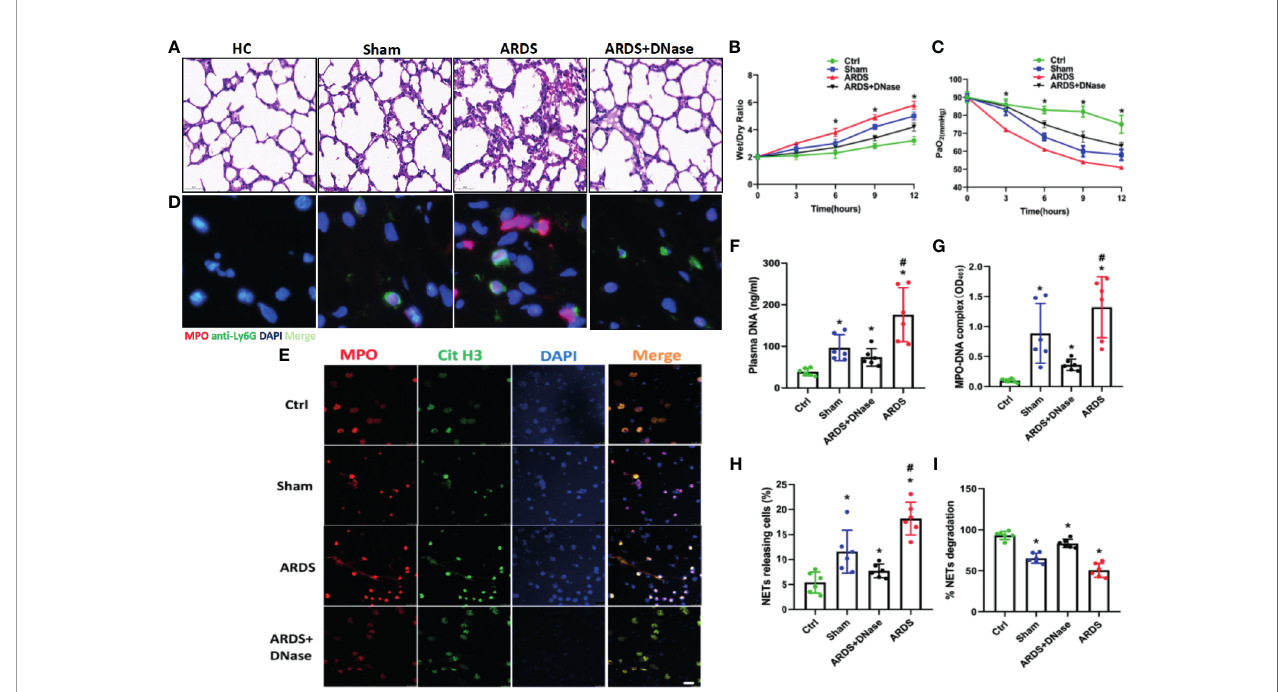
FIGURE 2 | NETs increase in a sepsis-induced lung injury model. (A) Lung tissues were collected from C57BL/6 mice in the control group, sham group, ARDS group, or ARDS+DNase group. H&E staining was performed on paraf fi n-embedded sections of mouse lungs to detect lung injury. (B) Changes in the lung wet/dry ratio in the four groups (C) . Changes in PaO 2 as the processing time increased in the four groups. (D) Immuno fl uorescence of lung tissue in red (MPO) and blue (DAPI). (E) Fluorescence imaging of mouse peripheral blood neutrophils among the healthy control, sham, ARDS, and ARDS+DNase groups. The sections were immunostained with MPO (red) and CitH3 (green), and DAPI (blue) was used to counterstain the nuclei. (F) . Ex vivo plasma DNA. (G) MPO-DNA complex. (H) NET- releasing cell count assay. (I) NET degradation among the healthy control, sham, ARDS, and ARDS+DNase groups (n=6). P < 0.05 (*) and P < 0.05 ( # ) compared to baseline healthy controls and the sepsis group were considered statistically signi fi